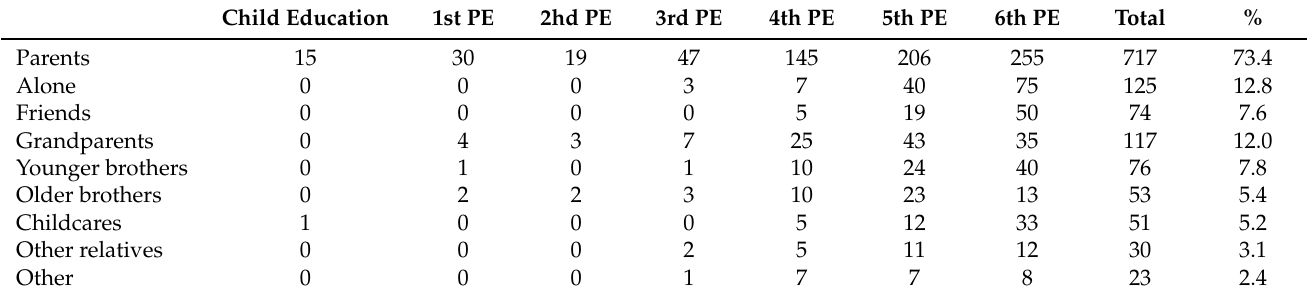
Table 5. Accompaniment of Child Education and Primary School students. Percentages refer to the total number of students surveyed at the Child Education and Primary School levels